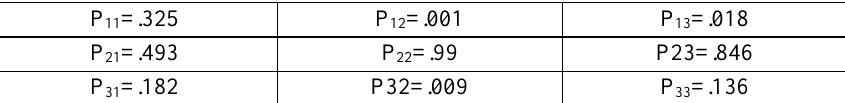
Table 5: Results of transfer matrix between regimes (authors’ calculations) P 11 =.325 P 12 =.001 P 13 =.018 P 21